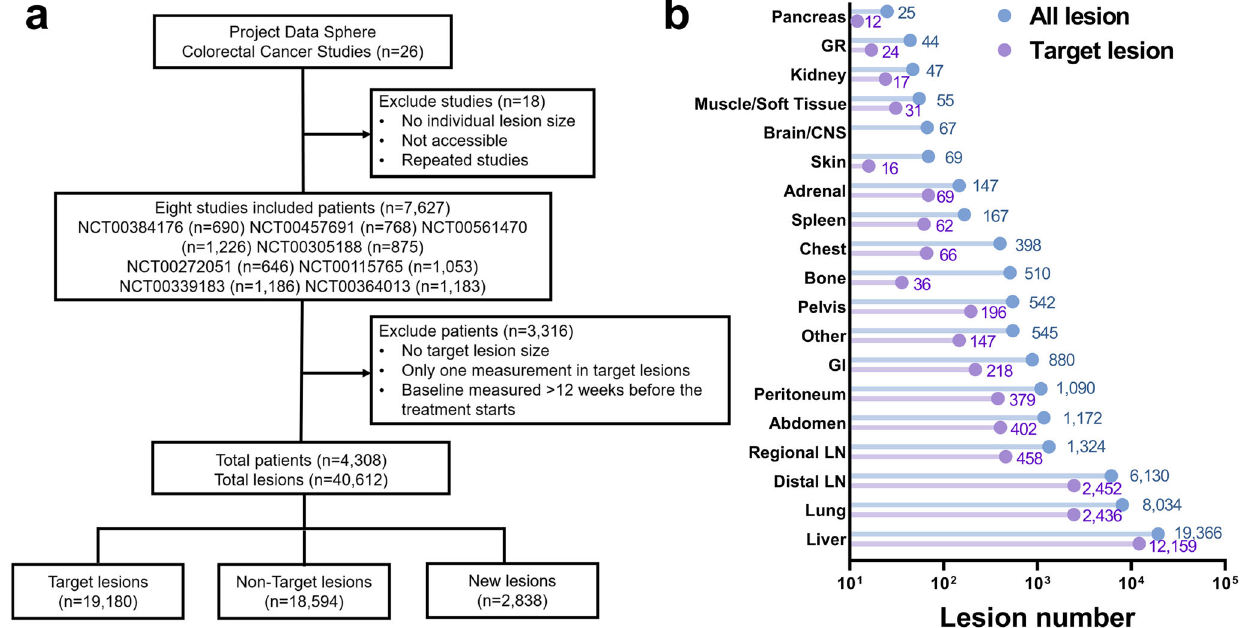
Fig. 1 | Data source. a CONSORT diagram of metastatic colorectal cancer data inclusionandexclusioncriteria. b Thenumberofalllesions(target,non-target,and new) and target lesions across organs. GR Genitourinary and Reproductive, CNS